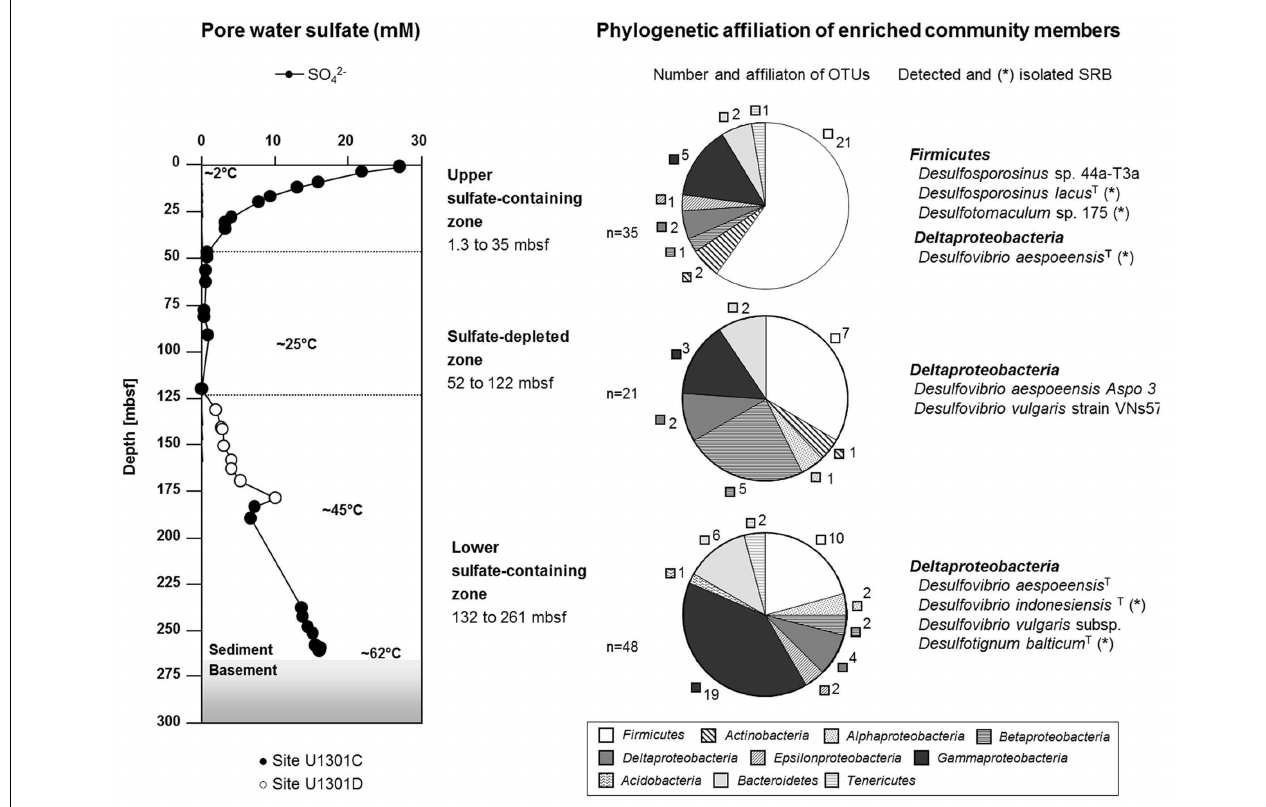
bacteria with special emphasis on sulfate-reducing bacteria. Operational taxonomic units (OTUs) detected via PCR–DGGE are defined at 97% sequence